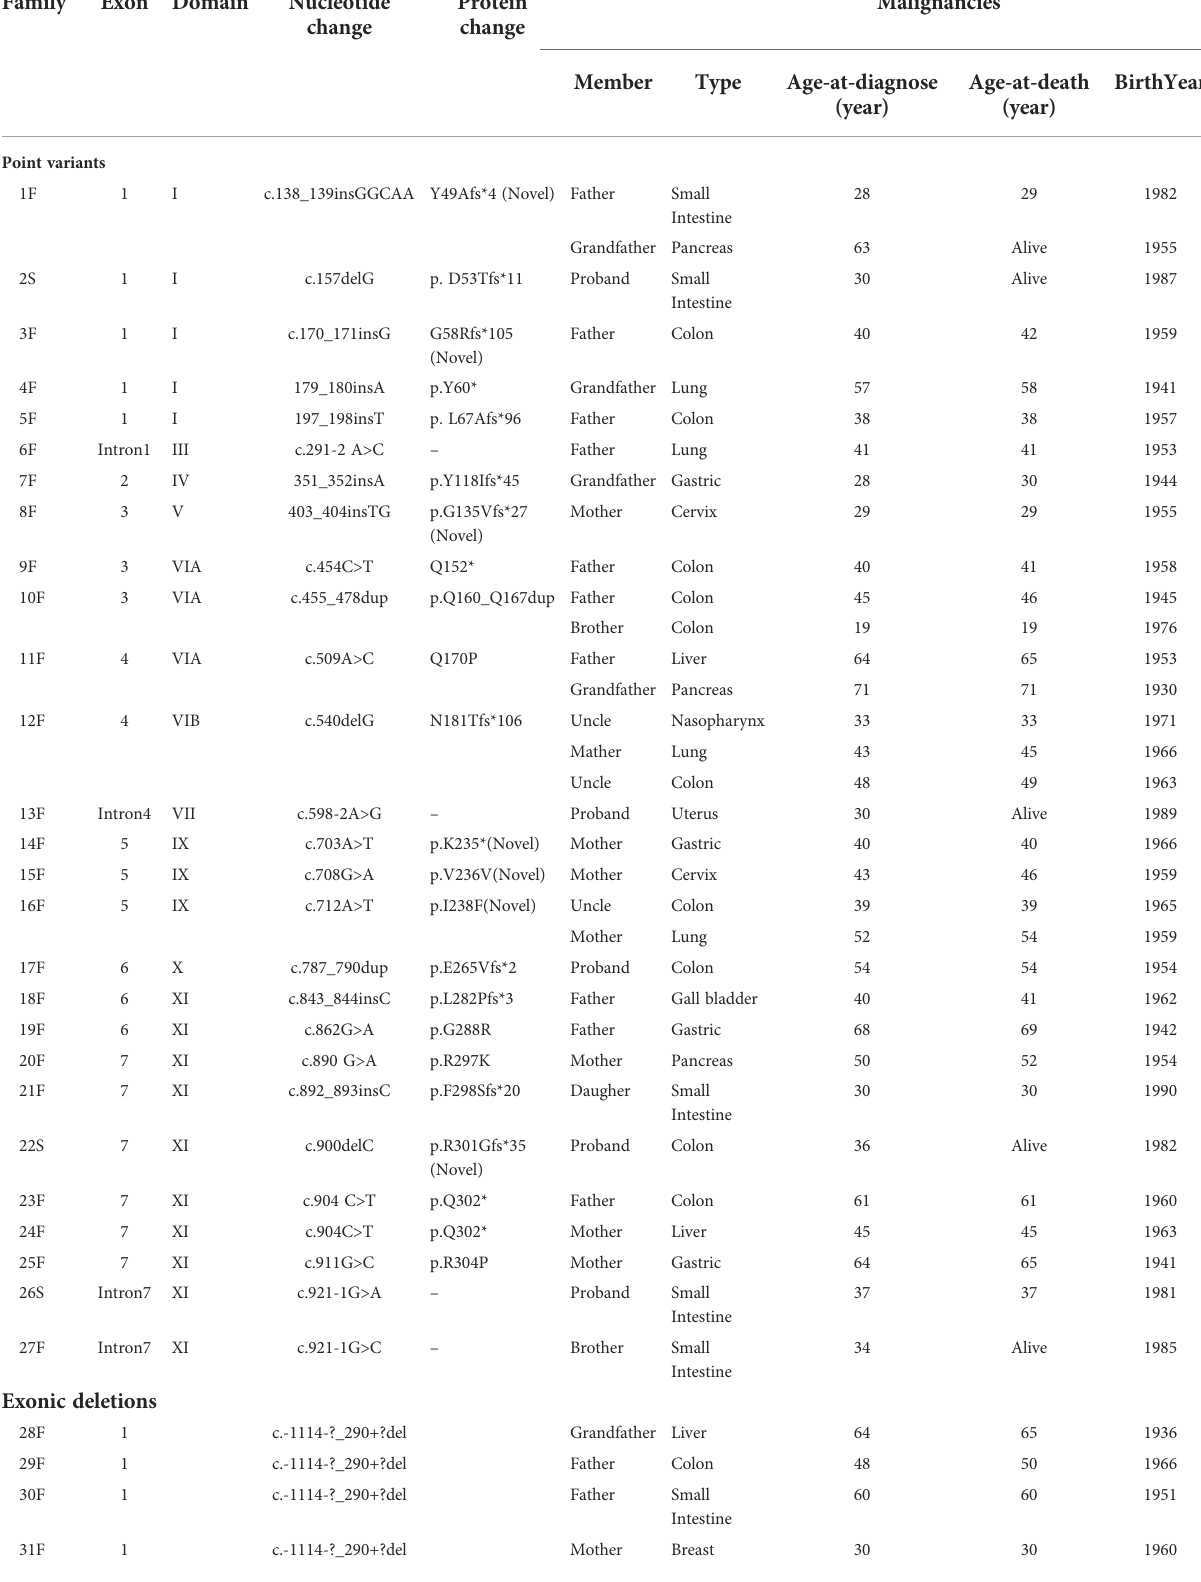
TABLE 5 STK11 gene variations of PJS patients with cancers from 35 different